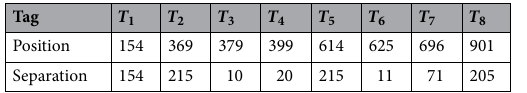
Table 1. Tag positions along the